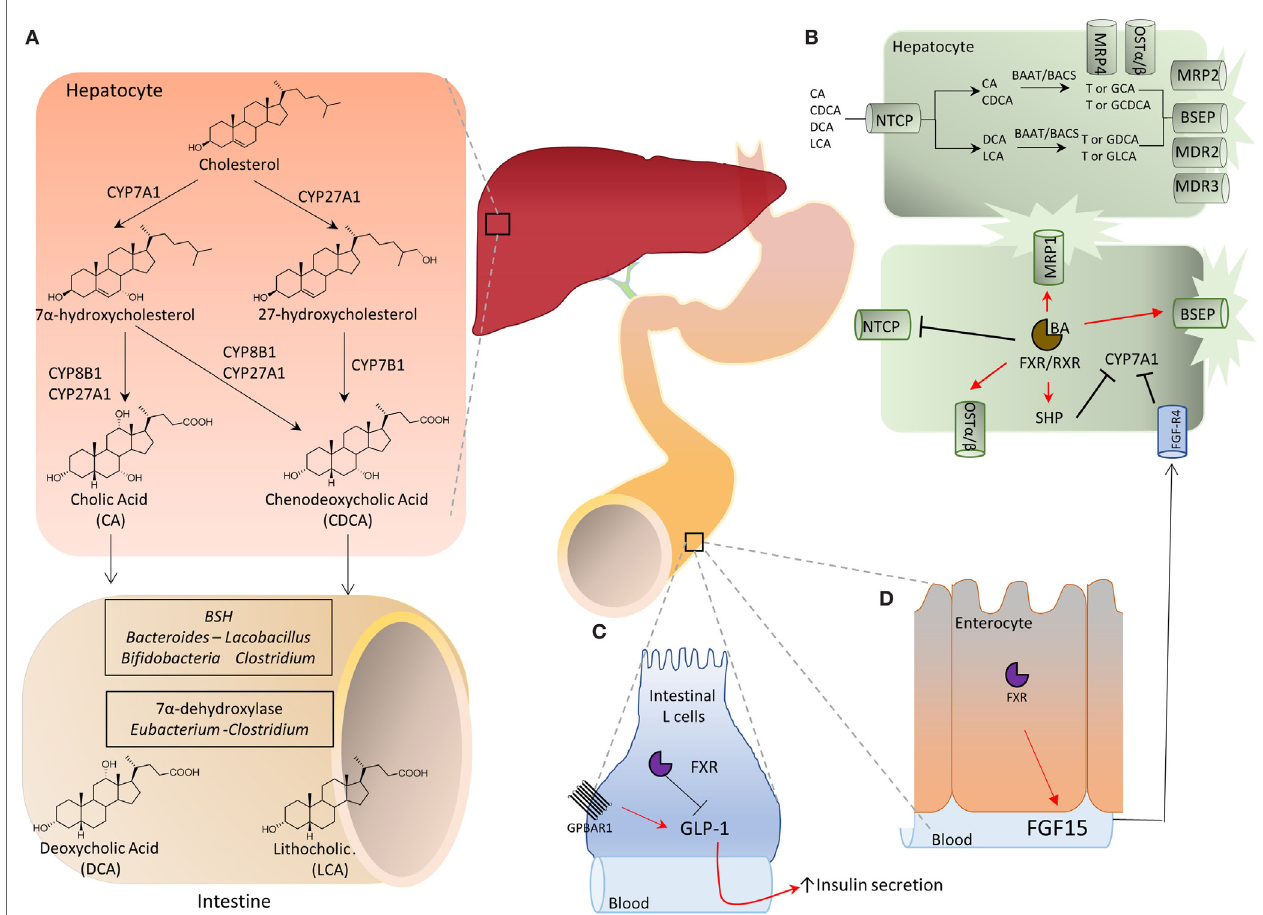
FiGuRe 1 | (A) Bile acids are synthesized in the liver from cholesterol by two metabolic pathways known as the neutral (or classical) and the acidic (alternative) pathways. In the classical pathway, cholesterol is metabolized to 7 α -hydroxycholesterol by cholesterol 7 α -hydroxylase (CYP7A1) and then to cholic acid (CA) by sterol 12 α -hydroxylase (CYP8A1) or to chenodeoxycholic acid (CDCA) by mitochondrial sterol 27-hydroxylase (CYP27A1). On the other hand, in the acidic pathway, CYP27A1 converts cholesterol into 27-hydroxycholesterol which is then metabolized by 25-hydroxycholesterol 7 α -hydroxylase (CYP7B1) into CDCA. The two primary bile acids, CA and CDCA, are then secreted into bile ducts and transported to the intestine where they are respectively converted by microbial bile salt hydrolases, an enzyme expressed predominantly by Bacteroides , Clostridium , Lactobacillus , and Bifidobacteria , and by a bacterial 7 α -dehydroxylase, mainly expressed by Clostridium and Eubacterium , in deoxycholic acid (DCA) and in lithocholic acid (LCA) called secondary bile acids. (B) Bile acid metabolism in liver cells and adaptive changes activated in cholestasis by Farnesoid-X-Receptor (FXR). Na + -taurocholate cotransporting polypeptide (NTCP) is a basolateral transporter that allow uptake of bile acids (CA, CDCA, DCA, and LCA) by hepatocytes. Primary and secondary bile acids are then amidated with glycine or taurine by bile acid-CoA:amino acid N -acyltransferase (BAAT) or bile acyl CoA synthetase and then secreted again into bile ducts through the apical transporters bile salt export pump (BSEP), multidrug resistance-associated protein 2, and multidrug resistance protein 2 and 3. Alternatively, an outflow occurs via the basolateral transporters MRP4 and organic solute transporter α / β (OST α / β ). The main regulatory mechanism in this pathway is contributed by the FXR which, once activated by its endogenous ligand CDCA, represses the transcription of CYP7A1 through the small heterodimer partner (SHP), thus inhibiting the classical pathway of bile acids synthesis. Furthermore, the activation of FXR up-regulates the transporters OST α / β , MRP1, and BSEP, and down-regulates NTCP, promoting the bile acids export. (C,D) Activation of intestinal FXR on enterocytes causes the release of fibroblasts growth factor (FGF)-15 (FGF-19 in humans) which binds to the FGF receptor 4 (FGF-R4) on hepatocytes and inhibits CYP7A1 transcription. Further on, in the intestine secondary bile acids cause a G-protein bile acid receptor 1-dependent release of glucagon-like peptide 1 (GLP-1) from intestinal “L” endocrine cells. GLP-1, in its turn, regulates insulin secretion by pancreatic β -cells.